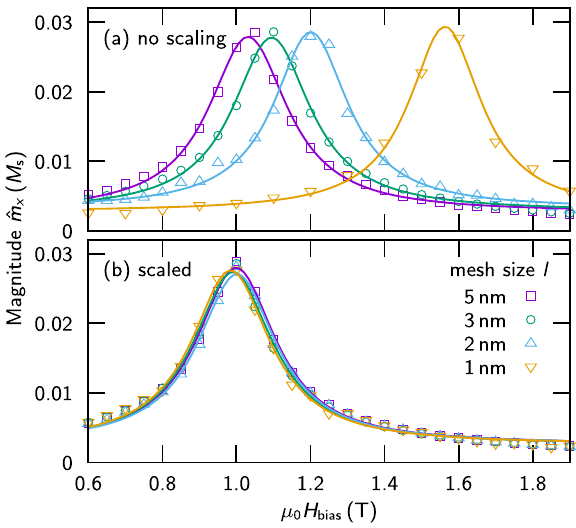
Fig. 2 FMR curves without magnetostatic fi eld. FMR curves obtained with sLLG without demagnetization fi eld for different mesh sizes. The symbols mark the computed results and the solid lines are the respective fi ts by Lorentz functions. While without scaling ( a ) the curves are shifted to higher bias fi elds, scaling the intrinsic properties ( b ) shifts the peaks back on top of each